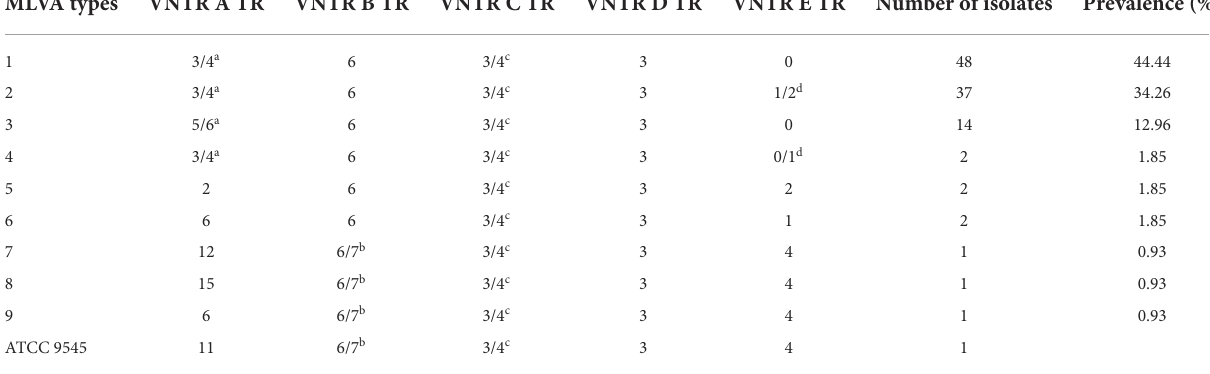
TABLE 1 Prevalence of different ERIC I subtypes distinguished by MLVA